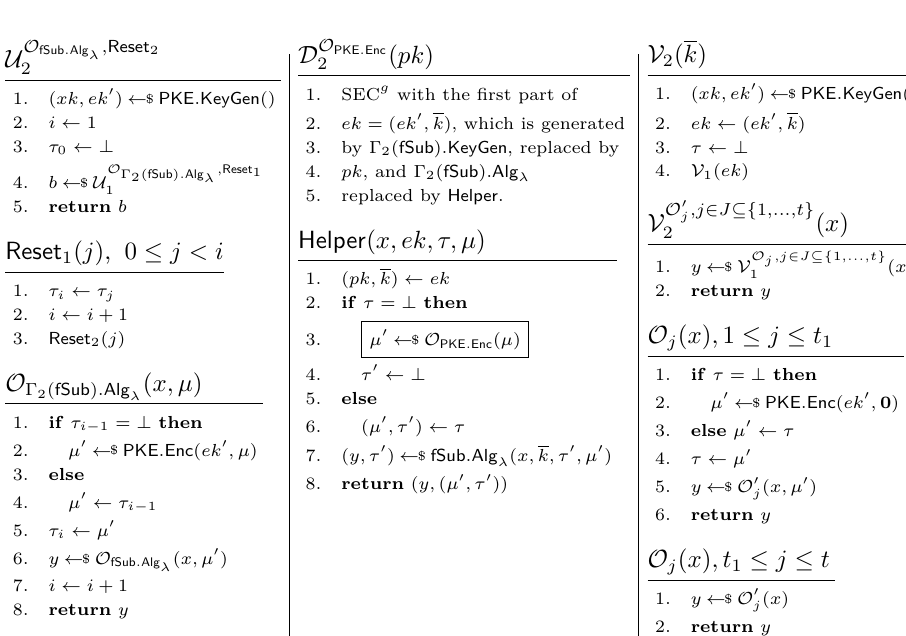
Figure 18: Adversaries U 2 , D 2 , and V 2 for the proof of Theorem 6. For U 2 and V 2 , queries made by U and V to their oracles are answered by using the oracles provided to them as 1 1 indicated. D runs the indicated code to simulate the SEC g game, and any oracle query 2 that would use Γ ( fSub ) . Alg ( x, ek, τ, µ ) is answered using the code in Helper 2 λ